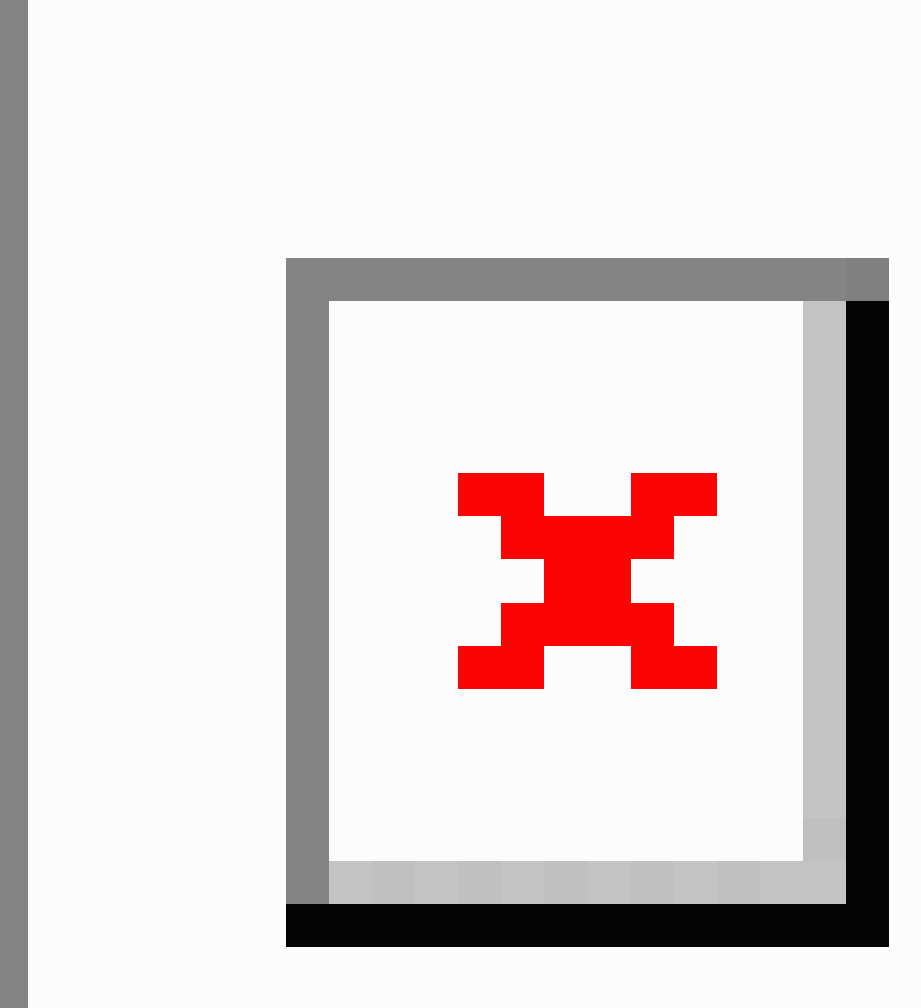
Figure 2. System screenshot